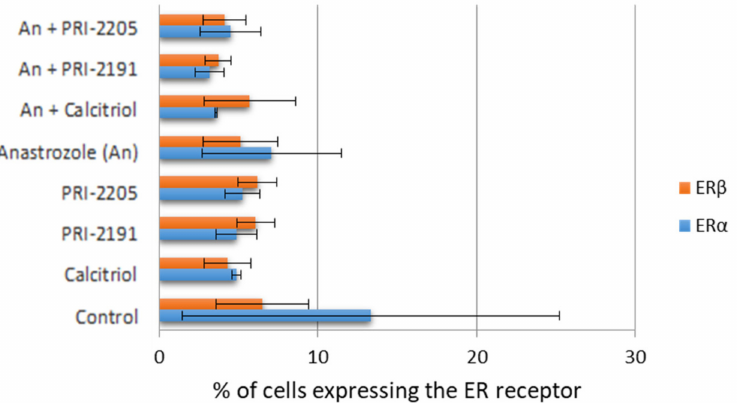
Figure 4. Expression of the estrogen receptors ER α and ER β in the MCF-7 breast cancer cell line after 72 h of treatment with calcitriol, PRI-2191 and PRI-2205, and anastrozole as measured by flow cytometry. Calcitriol, PRI-2191, and PRI-2205 were used at the concentration of 100 nM and anastrozole at the concentration of 0.1 mg/mL. The test was performed three times, each time in